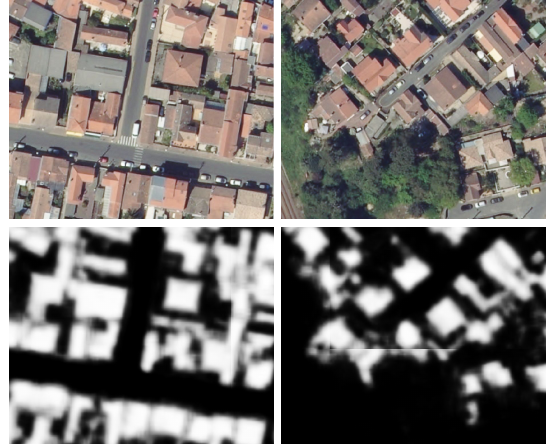
Figure 12. Extract of stitched raw predictions for building class Blending prediction with a windowing function: Work from (Chevalier, 2017) has been reused to improve the final result. The algorithm makes several predictions of a single tile with transformations applied (rotations, mirrors) and averages them.